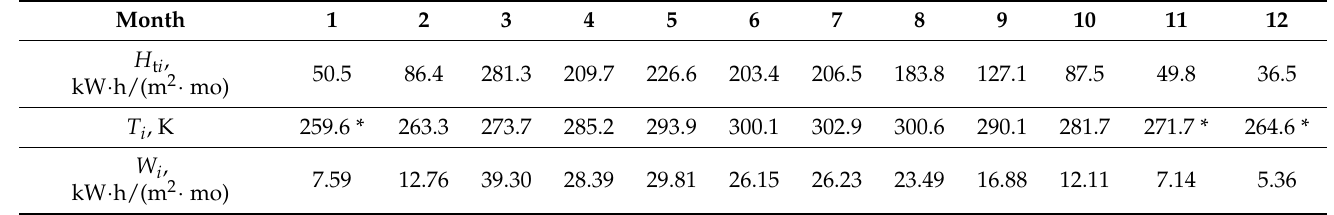
Table 10. Monthly solar irradiation H PV i , operating temperature of PV cells T i and generation W i by PV systems based on CPV modules with continuous tracking of the